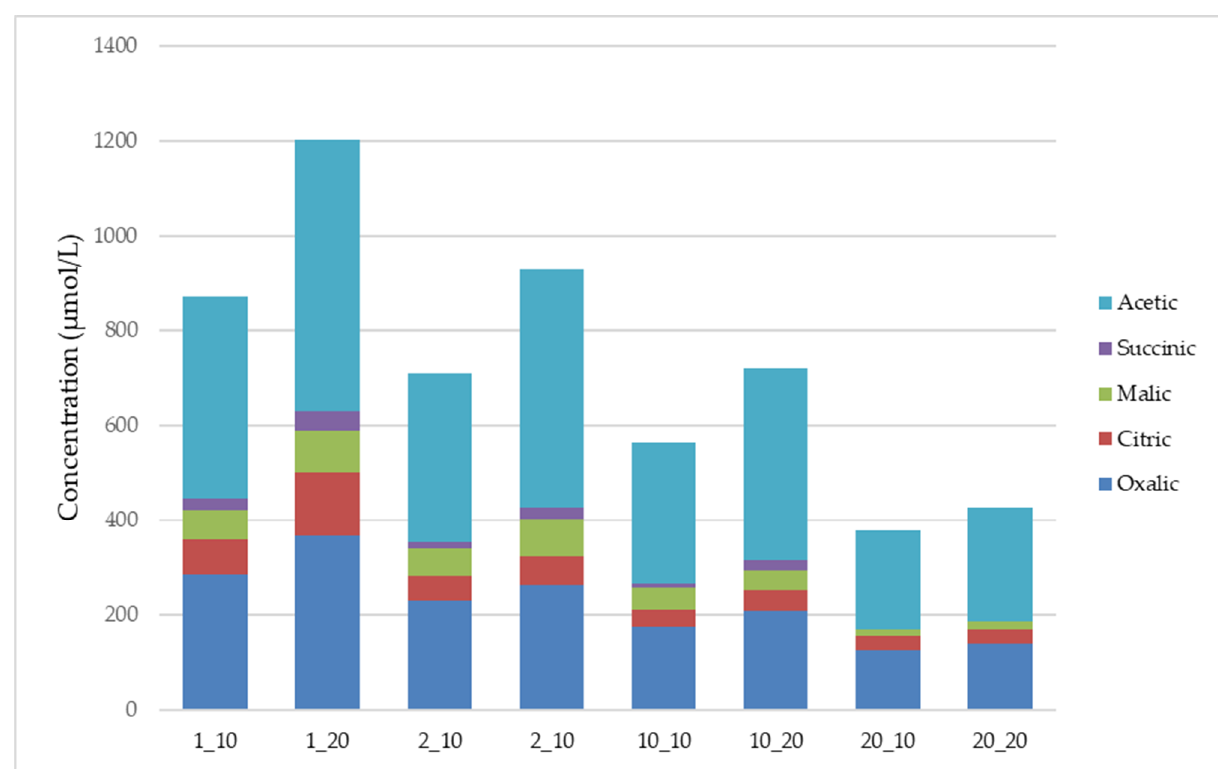
Figure 3. Organic acid production by Acetobacter tropicalis in bioleaching experiments of 1, 2, 10, and 20% S/L- pulp density of BR with 10 and 20% w / w of bacterium suspension in 20d (e.g., exp., 1_10: 1% S/L-pulp density of BR, 10% w / w bacterium suspension) .